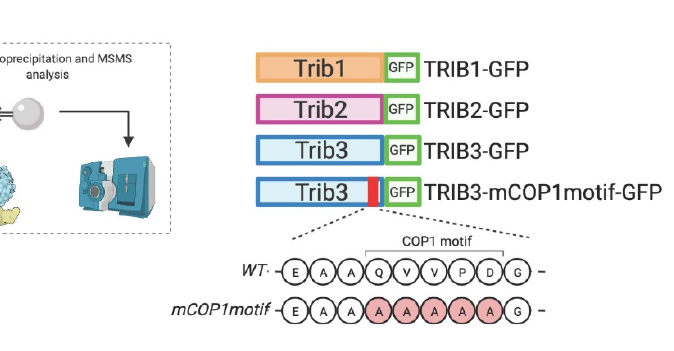
Figure 1. TRIB1, -2 and -3 interactomes in HEK293T cells. ( A ) Schematic representation of workflow followed for AP-MS experiments. ( B ) Volcano plots showing TRIB3 interactors compare to GFP control and TRIB3-mCOP1 interactors com- pared to WT TRIB3 in HEK293T cells. ( C ) Venn diagram of common and unique interactors between Tribbles family members. ( D ) TRIB3 interactors lost when comparing TRIB3 vs TRIB3-mCOP1 interactomes.